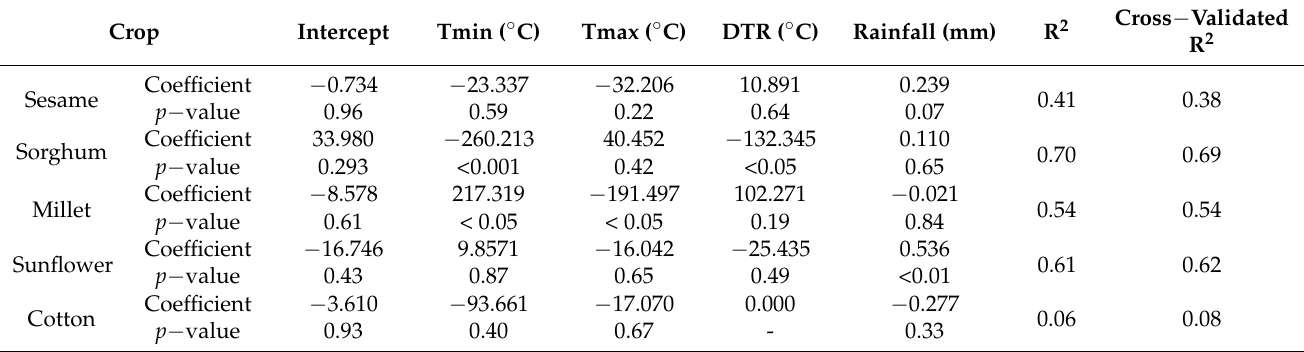
Table 5. Multiple linear regression terms and R 2 values for estimating yield, as a function of climatic variables, of five major crops grown in Gedaref state,